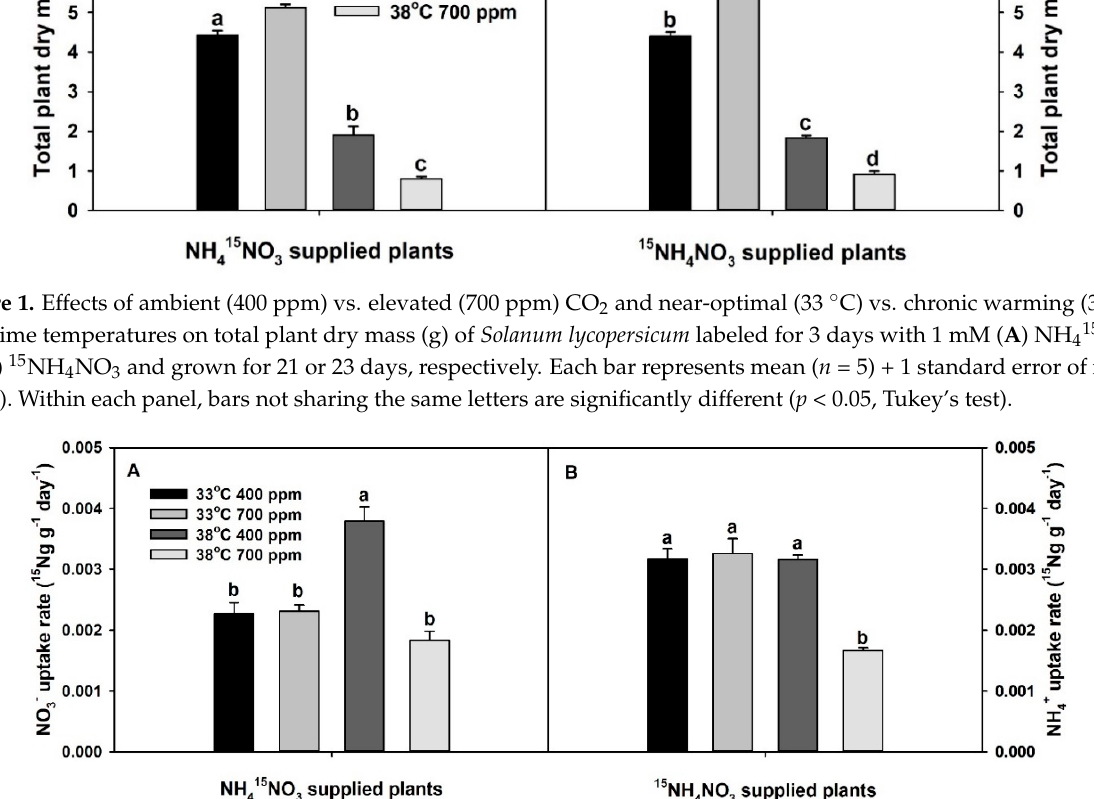
Figure 1. Effects of ambient (400 ppm) vs. elevated (700 ppm) CO 2 and near-optimal (33 °C) vs. chronic warming (38 °C) day-time temperatures on total plant dry mass (g) of Solanum lycopersicum labeled for 3 days with 1 mM ( A ) NH 415 NO 3 or ( B ) 15 NH 4 NO 3 and grown for 21 or 23 days, respectively. Each bar represents mean (n = 5) + 1 standard error of mean (SEM). Within each panel, bars not sharing the same letters are significantly different ( p < 0.05, Tukey’s test).